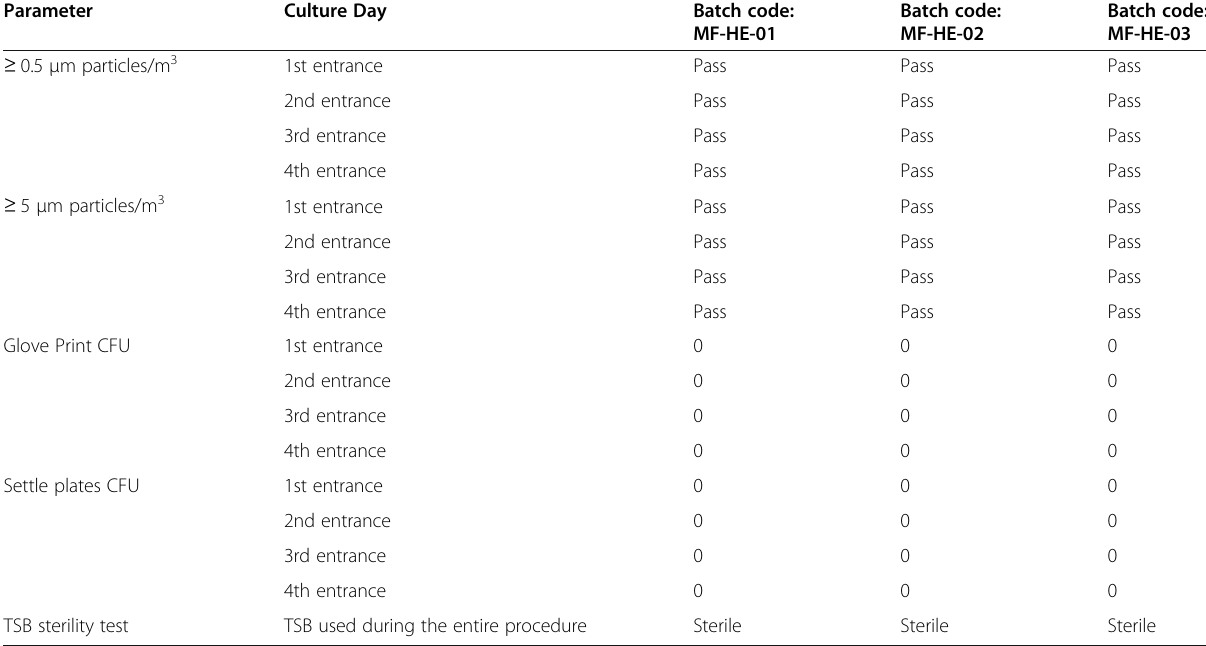
Table 5 Simulation tests results. Table summarizing results obtained with the three simulation test batches. Particles equal or greater than 0.5 µm and particles equal or greater than 5 µm in the cabinet (Grade A) met defined acceptance criteria. Gloves of the operating personnel and airborne microorganisms in cabinet (A grade) were monitored at each step of the simulation test. No microorganisms were detected in agreement with the acceptance criteria. Samples of the TSB, used throughout the